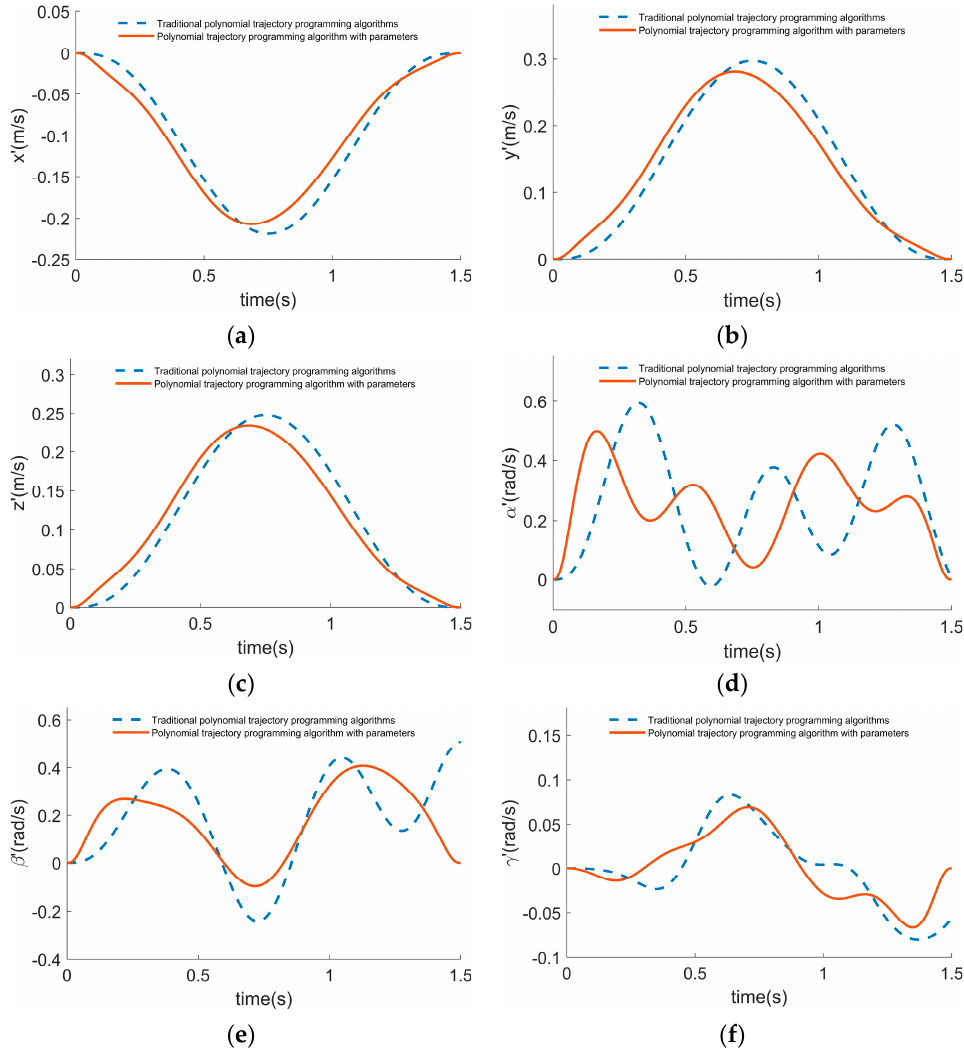
Figure 7. Velocity solved under two planning algorithms. ( a ) Comparison of x − direction velocity; ( b ) Comparison of y − direction velocity; ( c ) Comparison of z − direction velocity; ( d ) Comparison of α − angle velocity; ( e ) Comparison of β − angle velocity; ( f ) Comparison of γ − angle velocity.